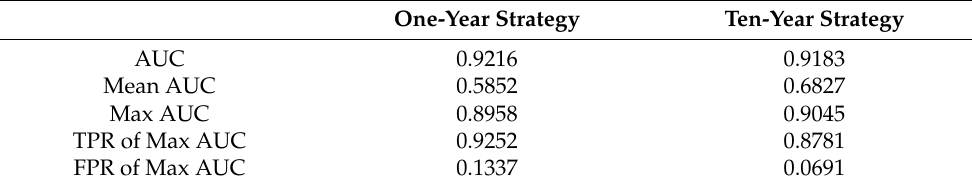
Table 2. Statistical results of ROC curves from the two strategies applied to Surat. Table 2. S tatistical results of ROC curves from the two strategies applied to Surat.